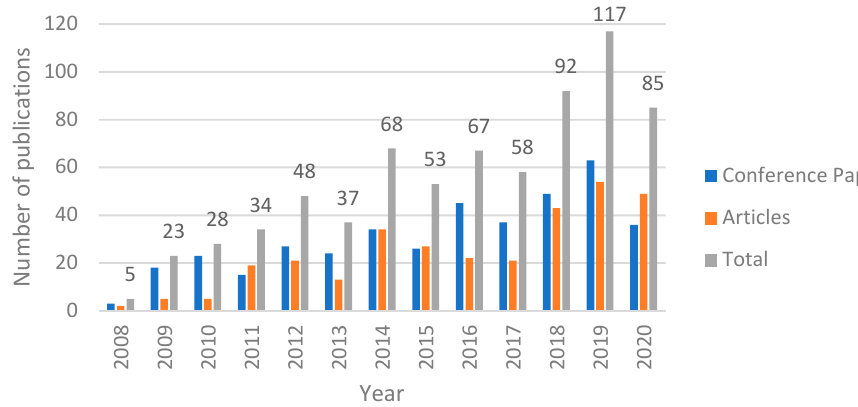
Figure 2. Number of finger-vein-related publications of Scopus per year for the last 13 years.